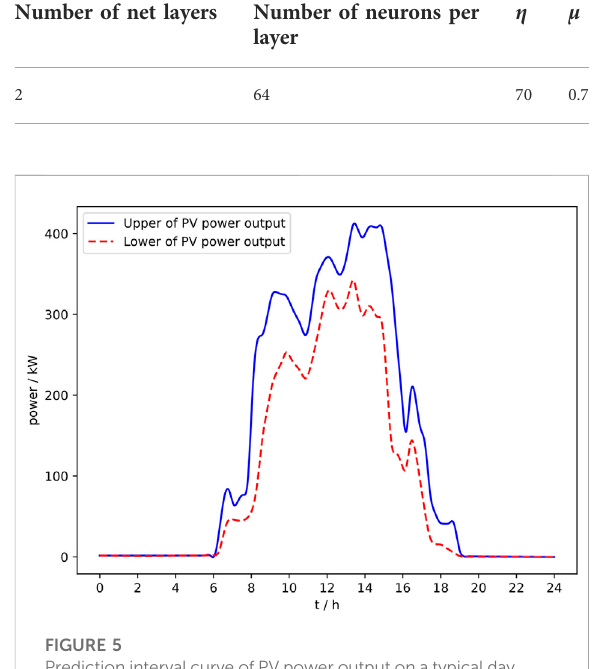
FIGURE 5 Prediction interval curve of PV power output on a typical day.